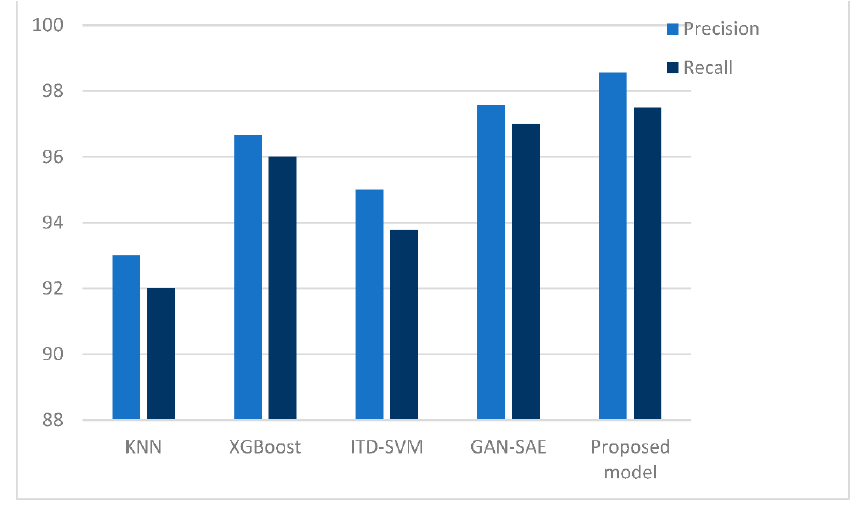
Figure 10. Comparison of Accuracy of some state-of-the-art techniques.